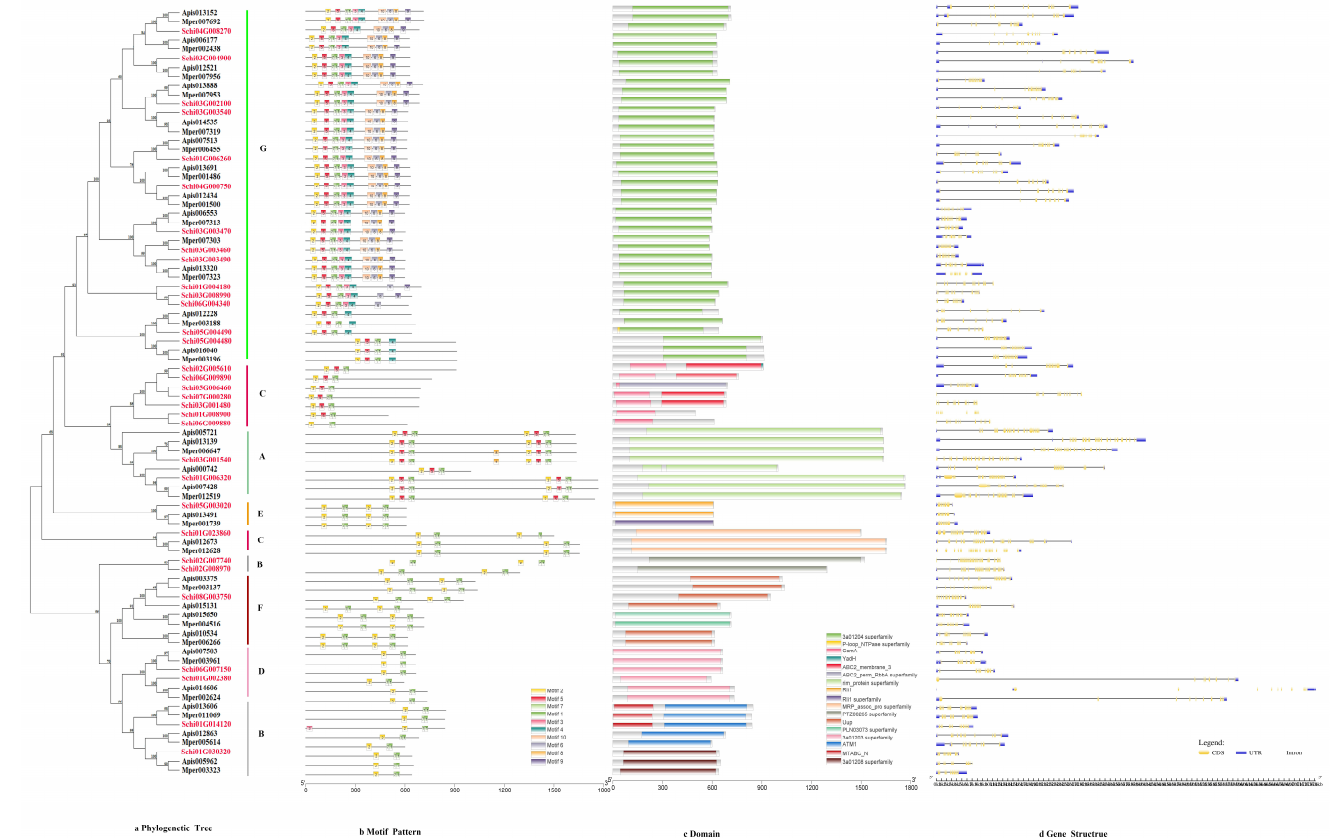
Figure 6. ( a ) Phylogenetic relationships, ( b ) conserved motifs, ( c ) domains and ( d ) gene structures of detoxification genes of the ABC gene family in S. chinensis , A. pisum , C. cedri , and M. persicae .